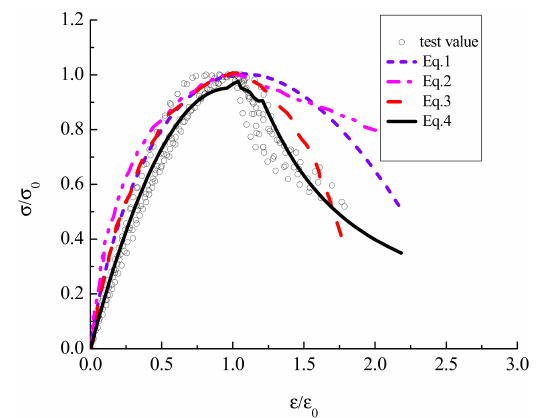
Figure 7. Correlation